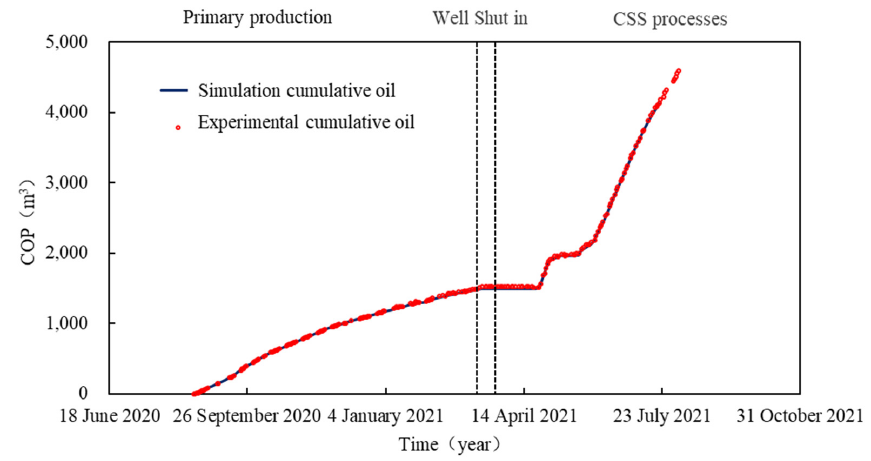
Figure 3. History matching of the COP values of the primary production and the first cycle of the CSS process of the horizontal CSS well.